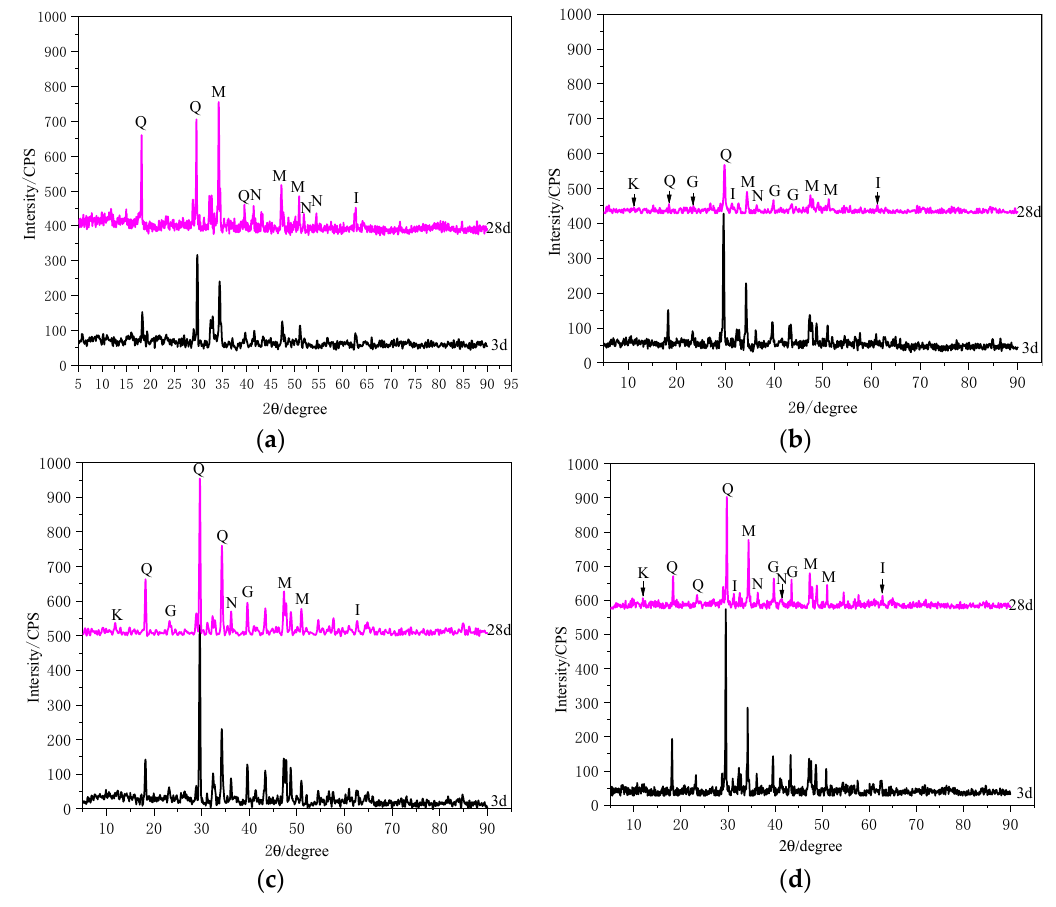
Figure 13. XRD of different samples. ( a ) XRD of p sample.( b ) XRD of PM1 sample. ( c ) XRD of PM2 sample. ( d ) XRD of PM3 sample. Q: C-S-H. M: Ca(OH) 2 . N: C 3 S + C 2 S. G: CaCO 3 . K: C 3 A · CaCO 3 · 11H 2 O. I: C 3 AH.